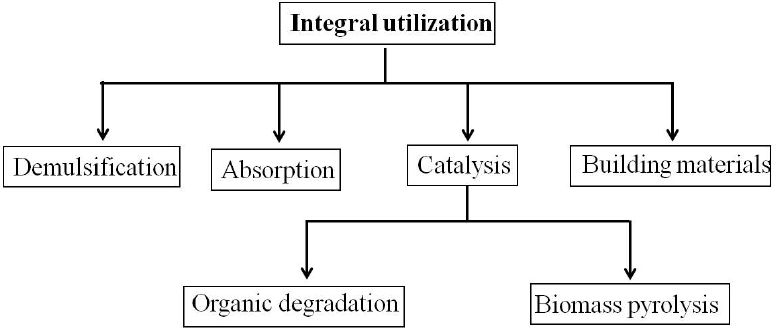
Figure 1. Graphic illustration of the integral use methods for dust.